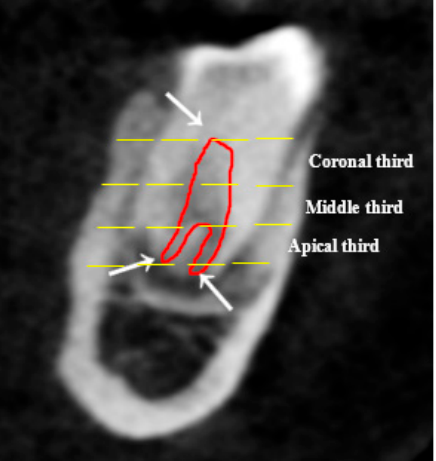
Figure 2. The sagittal view showed the root canal from orifice to portal of exit, one canal at ori- fice/coronal and the middle thirds, which split into two foramina apically; it is an example of Vertucci V and 1 FP 1,1,2 based on both Vertucci and Ahmed’s classification system of root canals.